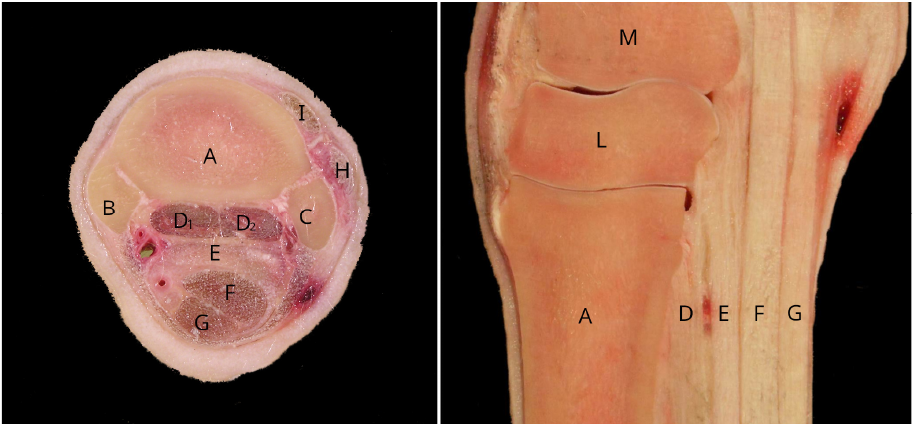
Figure 1. Cross-sectional ( left ) and sagittal ( right ) anatomical specimens of the proximal metacarpal region. (A) third metacarpal bone; (B) second metacarpal bone; (C) fourth metacarpal bone; (D1) medial lobe of the suspensory ligament; (D2) lateral lobe of the suspensory ligament; (E) accessory ligament of the deep digital flexor tendon; (F) deep digital flexor tendon; (G) superficial digital flexor tendon; (H) lateral digital extensor tendon; (I) common digital extensor tendon; (L) third carpal bone; (M) intermediate carpal bone.